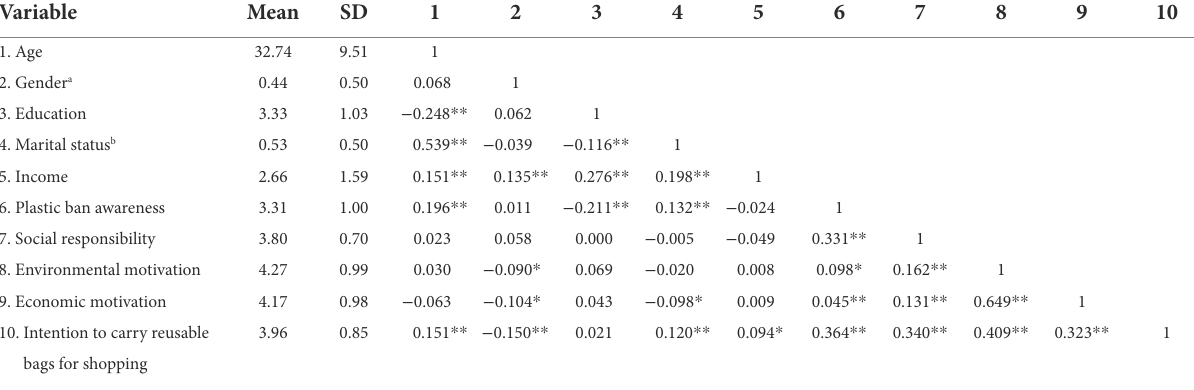
TABLE 1 Means, standard deviations, and Pearson’s correlations of the model variables ( N = 532).